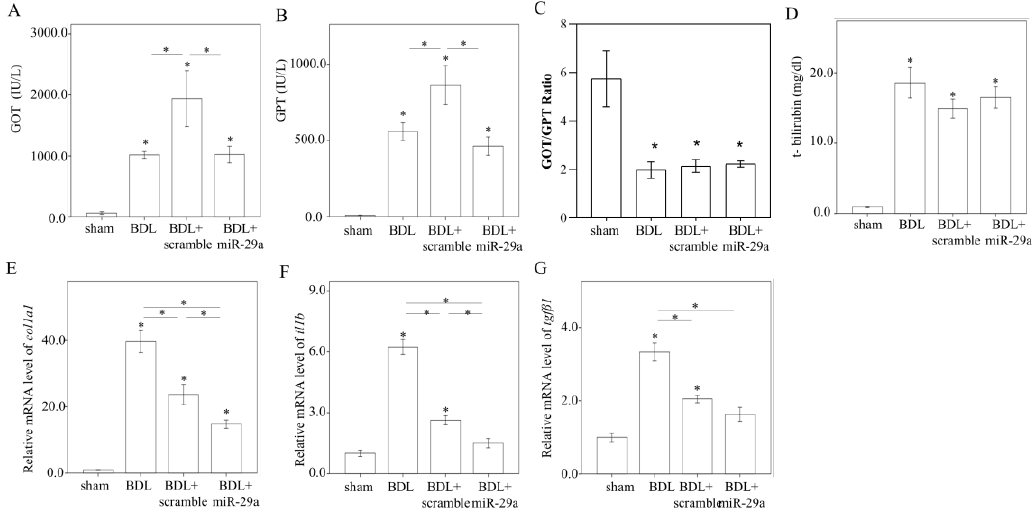
Figure 2. Exogenous miR-29a injection significantly reverses the markers assessing hepatic inflammation and fibrosis. ( A – D ) Serum GOT, GPT, GOT/GPT ratio, and total bilirubin. mRNA expression level of ( E ) colla1, ( F ) Il1b, and ( G ) tgfb1 . β -actin level is used as the normalization control.